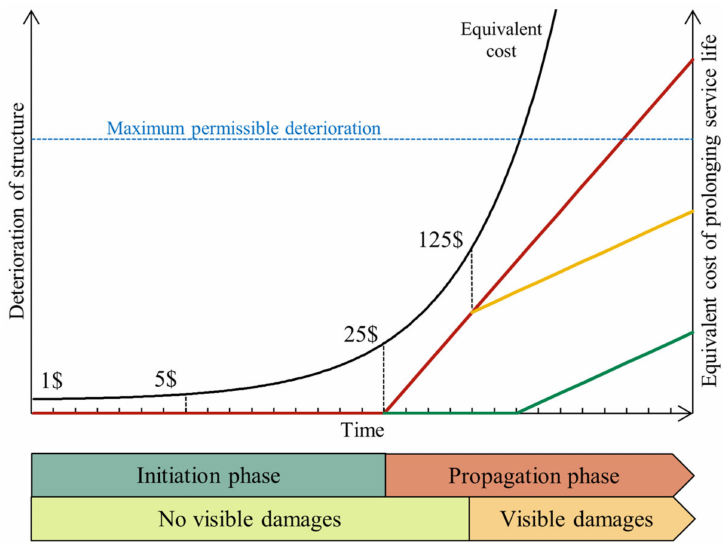
Figure 1. De Sitter’s “Law of Fives” in Tuutti’s diagram. Re-elaborated from